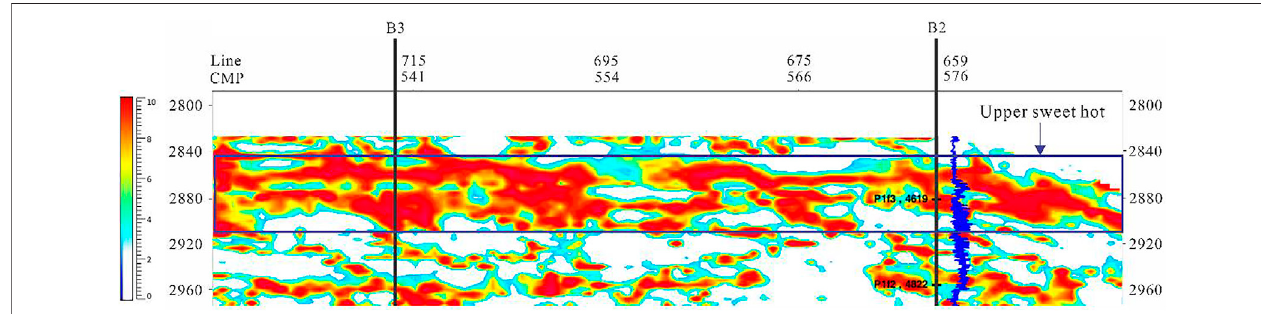
FIGURE 8 | Well B3-B2 fracture strength pro fi le.